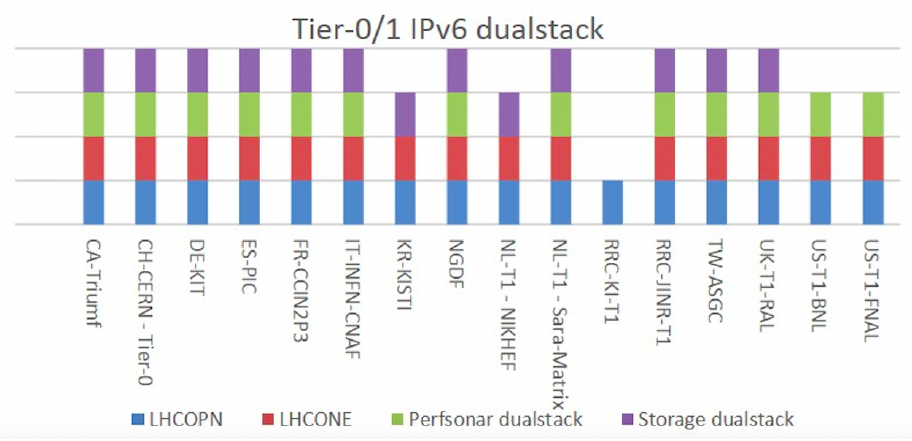
Figure 2. LHC Tier-0 and Tier-1 sites - Dual-stack readiness of LHCOPN, LHCONE, PerfSONAR and